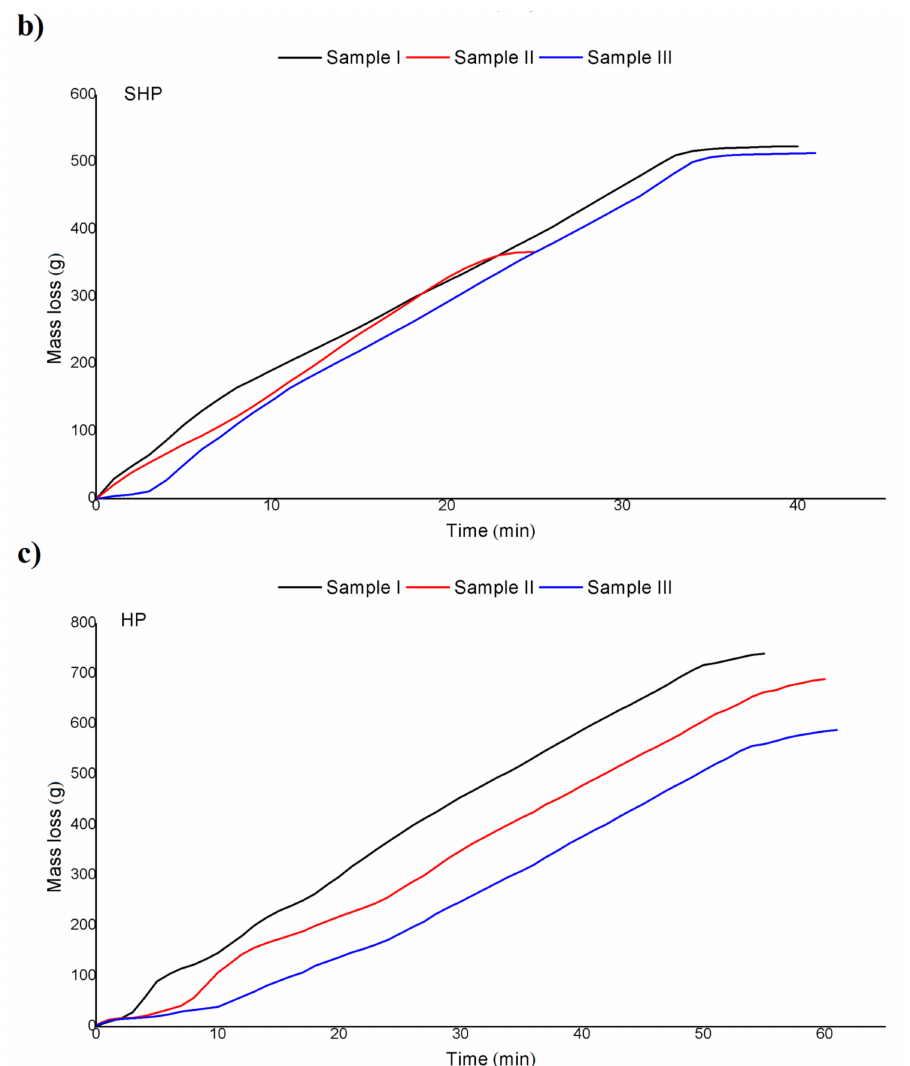
Figure 3. Mass loss rate during combustion of ( a ) sunflower husk, ( b ) sunflower husk pellets, and ( c ) hardwood